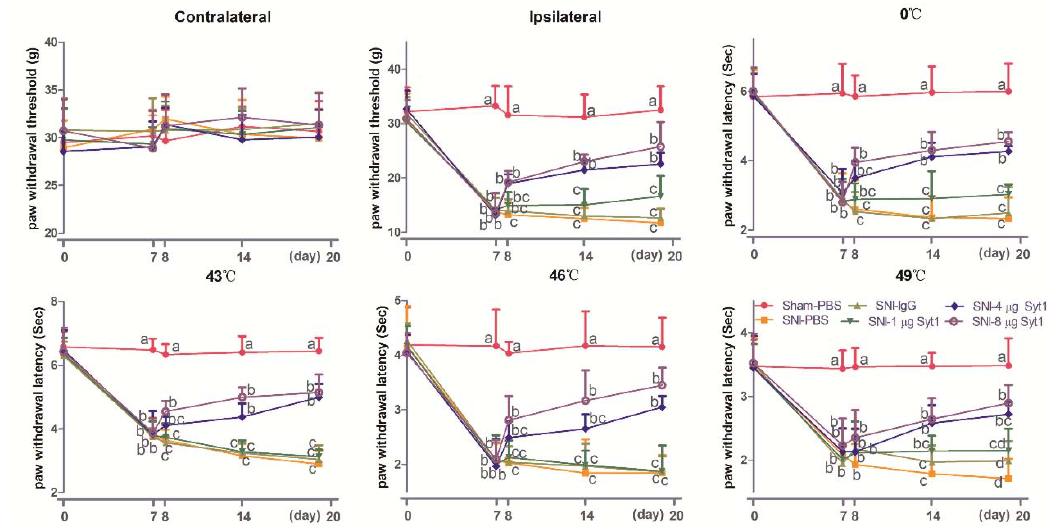
Figure 1. The distribution of Syt-1 immunoreactive cells in the spinal cord dorsal horn (SCDH). ( A , B ) The sketches and tissues (in laminae I-II) showed that SNI resulted in increased Syt-1 immunoreactive (Syt-1-IR), mainly in the laminae I-II of the SCDH. B shows the representative of immunohistochemistry from 3 animals. Red arrows show Syt-1 positive cells. Scale bars, 100 µ m.